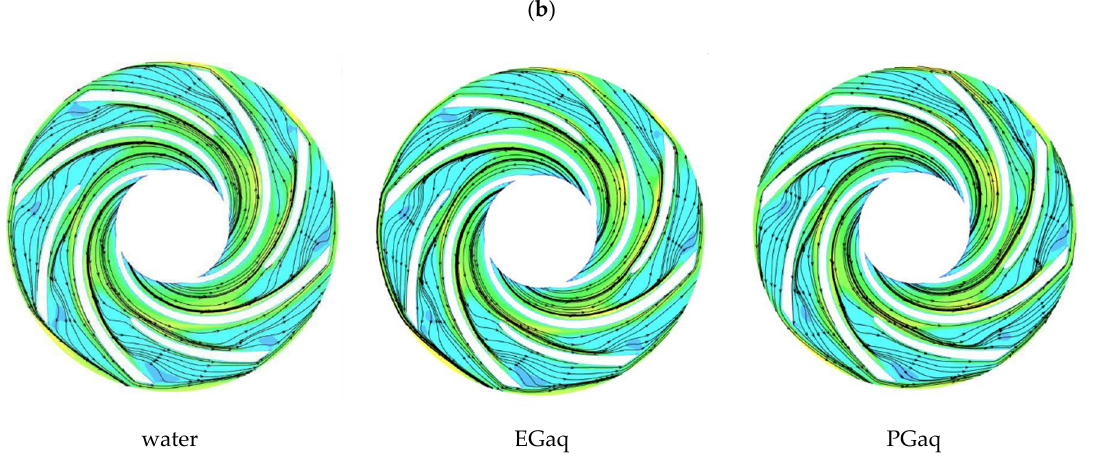
Figure 13. The velocity of the middle plane of the splitter blade impeller at different flow rates. ( a ) 0.7 𝑄 (cid:3031) ; ( b )0.7 𝑄 (cid:3031) ; ( c )0.7 𝑄 (cid:3031) ( a ) 0.7 Q d ; ( b ) 0.7 Q d ; ( c ) 0.7 Q d